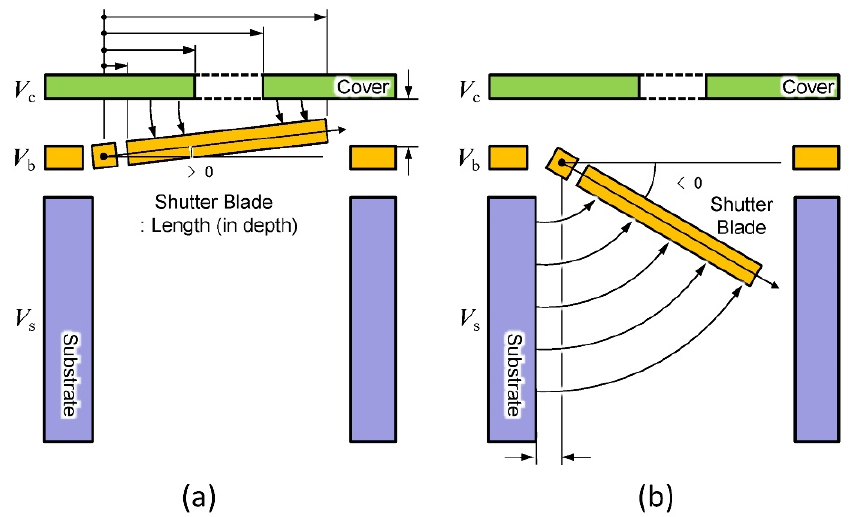
Figure 19. Side view of the three-port electrostatic mechanism. ( a ) The shutter blade locked upward for closing the aperture; ( b ) for opening the aperture, the shutter blade is retracted inward. Adapted from [116].